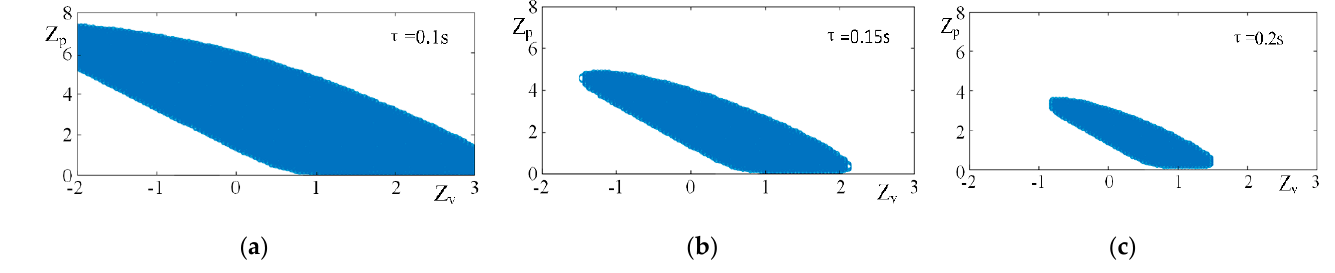
Figure 3. Stable region diagram under the influence of delay parameters τ . ( a ) τ = 0.1; ( b ) τ = 0.15 ( c ) τ = 0.2.